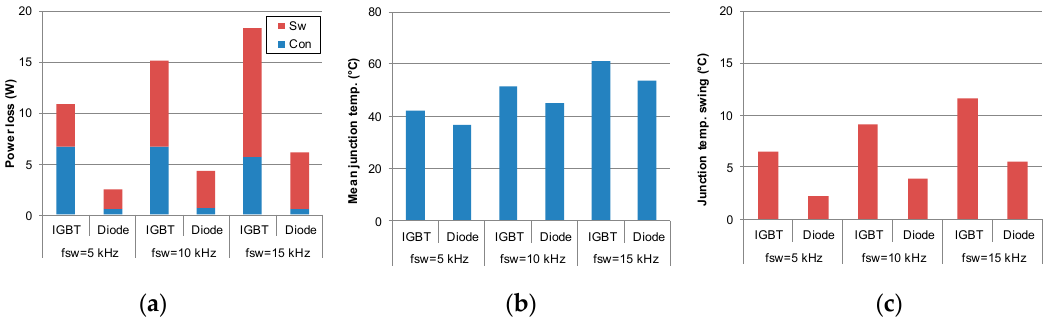
Figure 8. Impacts of various switching frequencies ( f sw ) on power module. ( a ) Loss dissipation. ( b )